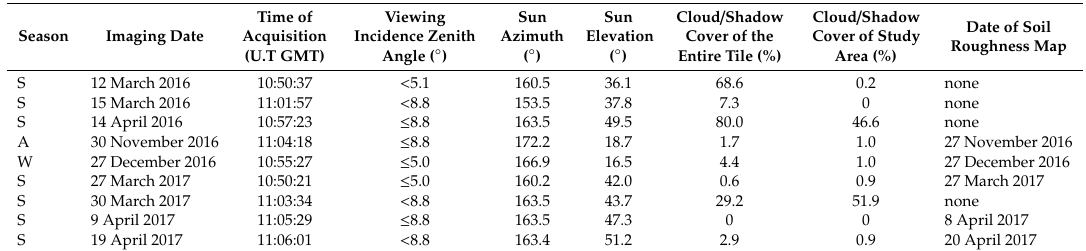
Table 2. Main characteristics of the studied scenes (tile TUDQ31): S, spring; A, autumn; W, winter.